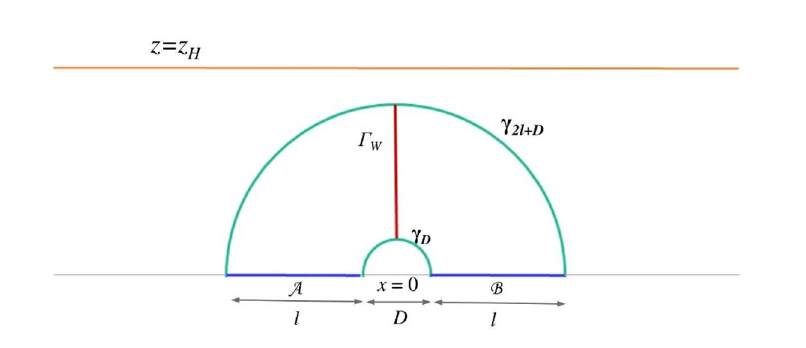
Figure 3. Schematic diagram of two disjoint subregions of width l separated by a distance D for the computation of